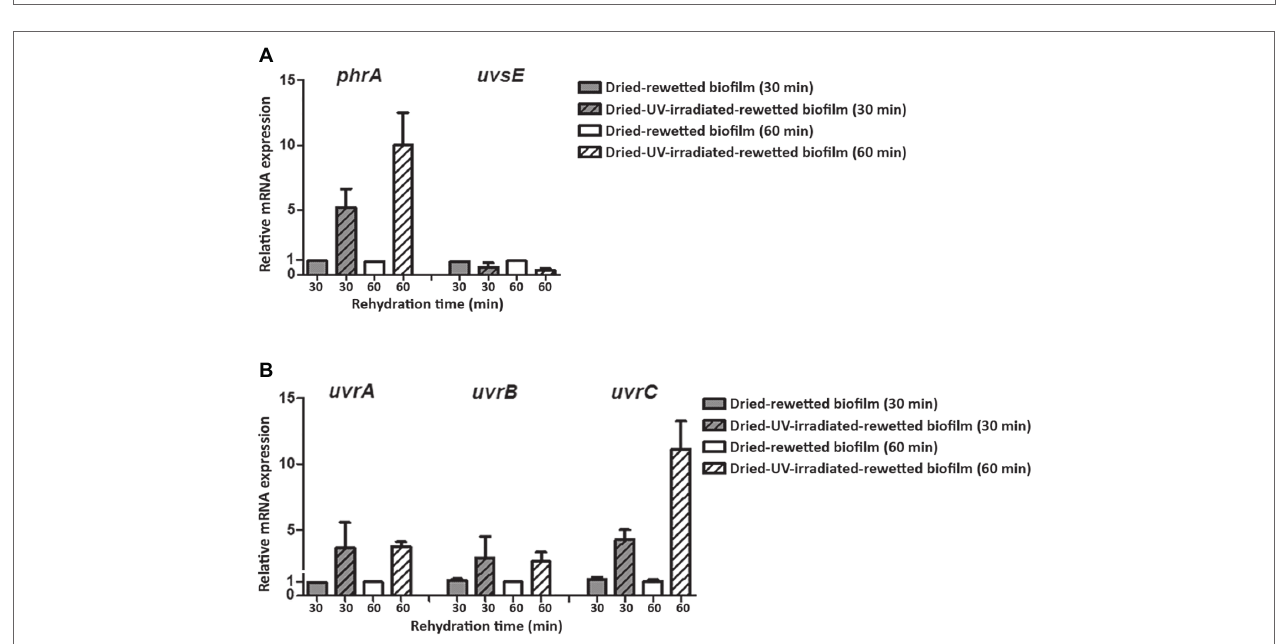
FIGURE 6 | Expression of DNA repair genes in dried-UV-irradiated-rewetted biofilm after 30 and 60 min of rehydration. Expression of phrA and uvsE gene (A) and of uvrA, uvrB , and uvrC genes (B) . Values of dried-rewetted biofilms after 30 and 60 min of rehydration were considered as control values and set to 1. Subsequent samples were compared in terms of fold regulation to control